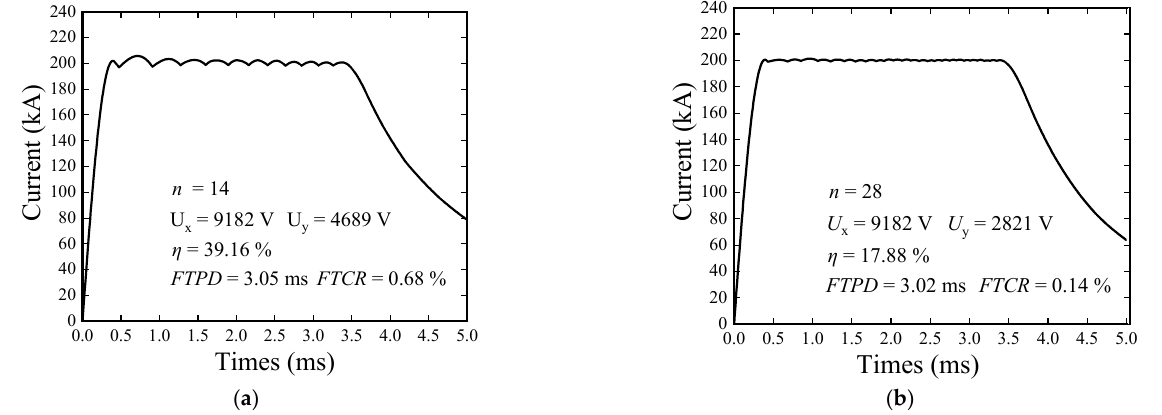
Figure 8. The current with different stability obtained with SCM. ( a ) Generally stable current. ( b ) Highly stable current.